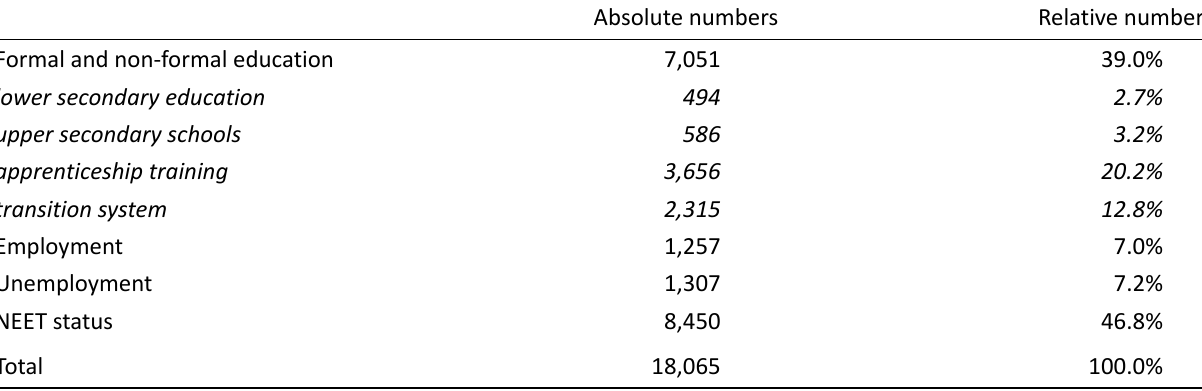
Table 1. Transition routes of students with a SEN curriculum 24 months after graduation or dropping out.